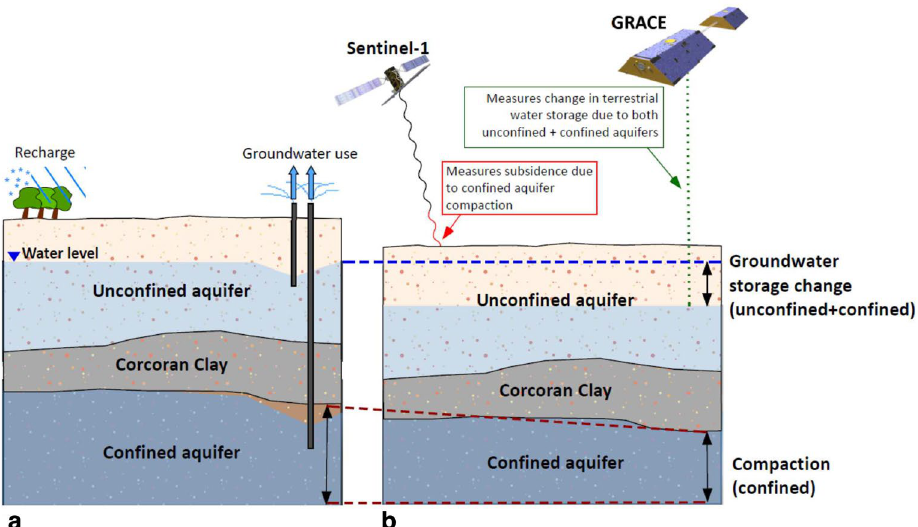
Figure 1. Schematic figure of the conceptual model of the Tulare basin aquifer. ( a ) The Corcoran clay separates the overlying unconfined aquifer from the confined aquifer below. Recharge occurs in the unconfined aquifer from snow, runoff, and precipitation. ( b ) Groundwater usage decreases overall terrestrial water storage in both the unconfined and confined regions (blue shaded region), which is detected by GRACE. Compaction (red dotted line), predominantly occurring in the confined aquifer, results in the line-of-sight displacement of the Earth’s surface measured by Sentinel-1 Synthetic Aperture Radar (SAR)